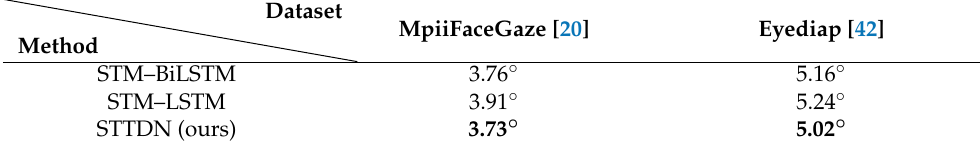
Table 3. The angular error of STM–LSTM, STM–BiLSTM,